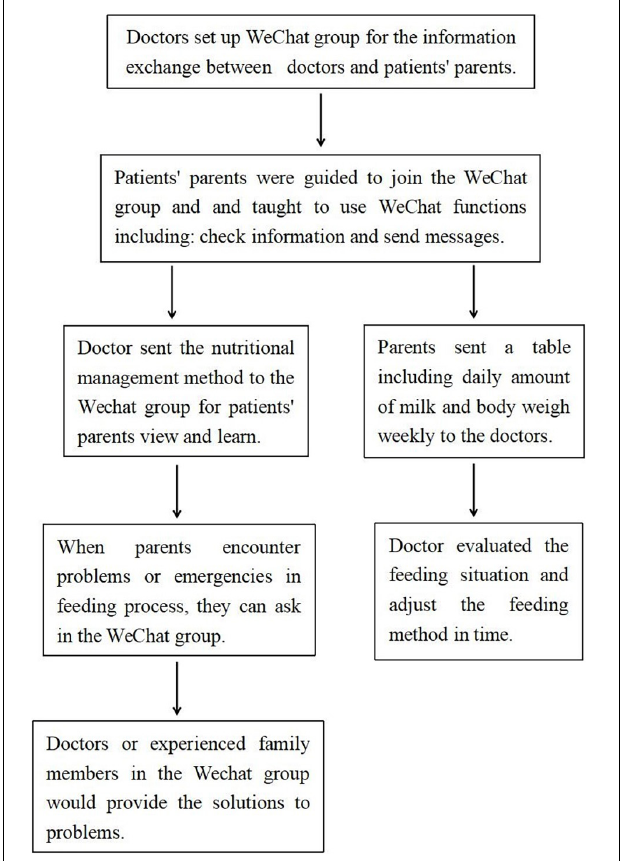
FIGURE 1 | The flow chartof remote management nutrition via